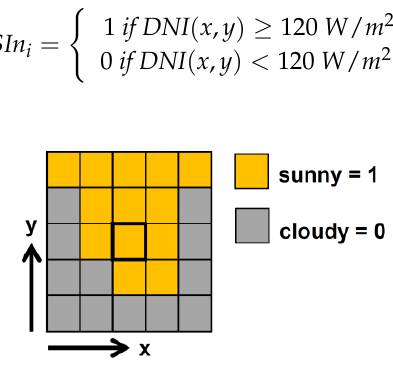
Figure 1. Demonstration for accounting for surrounding grid points. The target grid point is marked in the center.